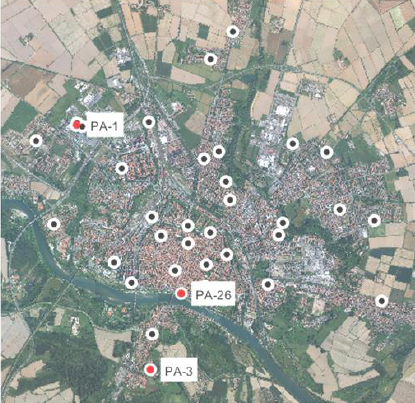
Figure 9. Map of the 37 outdoor sensors; the three ones selected are shown in red; their name is also displayed